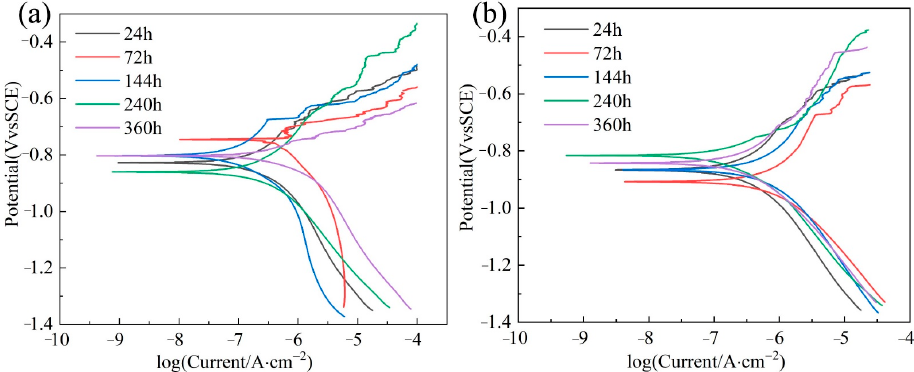
Figure 11. ( a ) Tafel of 5083Al after NSS at different times; ( b ) Tafel of Al 2 O 3 3D/5083Al after NSS at different times. Table 3. Tafel of 5083 Al after NSS at different times. Tafel of 5083 Al after NSS at Different Times Time/h